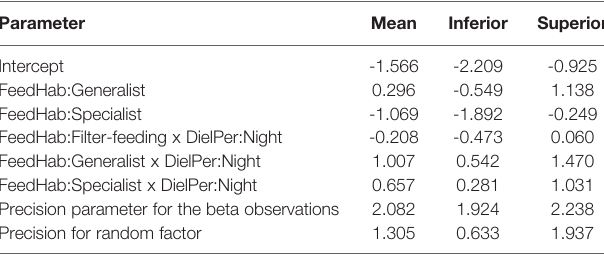
Tag deployment was included as a random